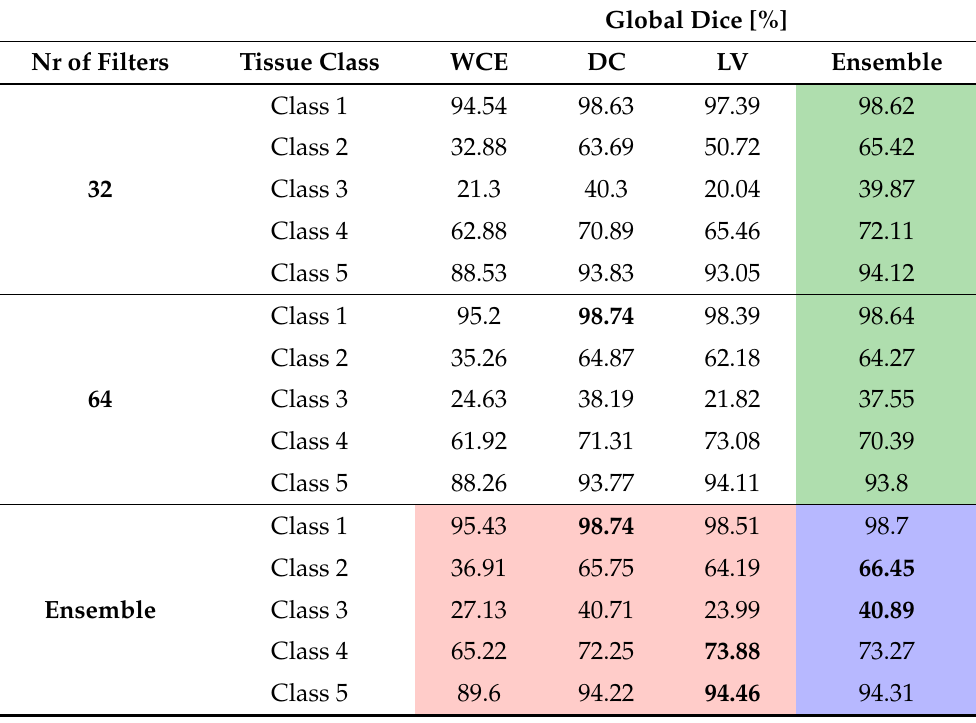
Table 4. Global Dice (in %): performance of the individual networks and ensembles of networks on development dataset from 5-fold cross validation. Only results from validation folds are reported. The results in the green fields show scores for the network ensembles over loss functions for a particular filter number (three networks), whereas in the red fields are results for networks with different number of filters combined for a particular loss function (two networks). The violet fields show the final ensemble where all six networks were combined. The best overall global Dice scores for each class across all configurations (single networks or ensembles) are shown in